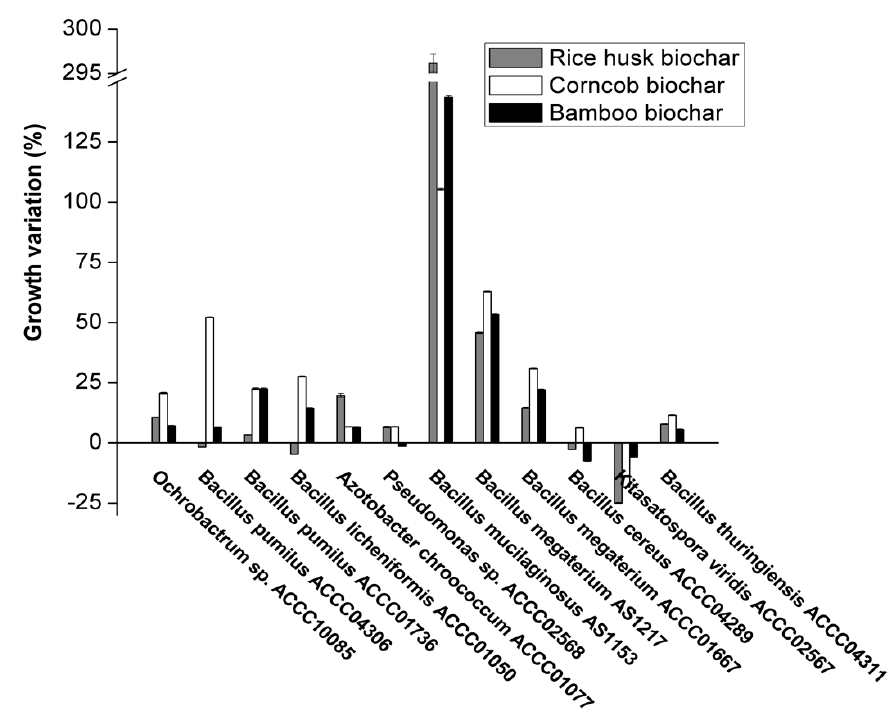
Figure 1. Impact of biochars derived from di ff erent feedstock on bacterial growth in the artificial culturing medium.